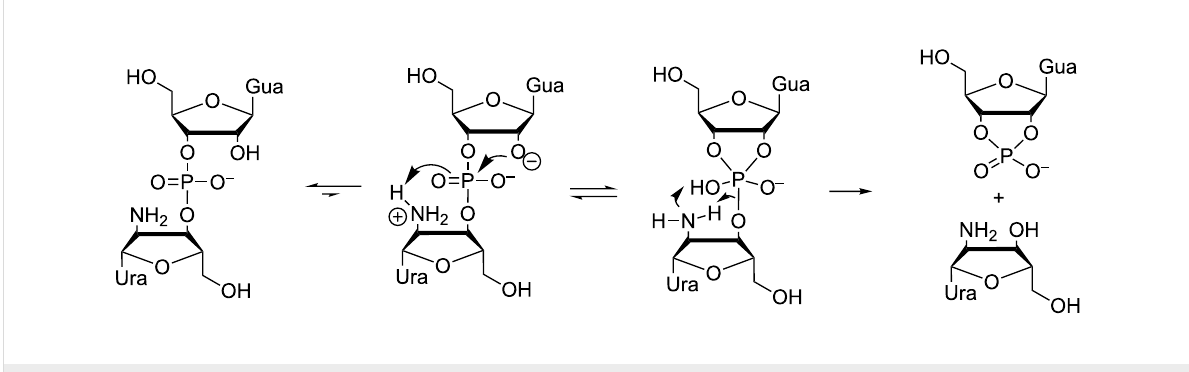
Scheme 10: Mechanism for the pH-independent cleavage of guanylyl-3´,3´-(2´-amino-2´-deoxyuridine) at pH 6-8